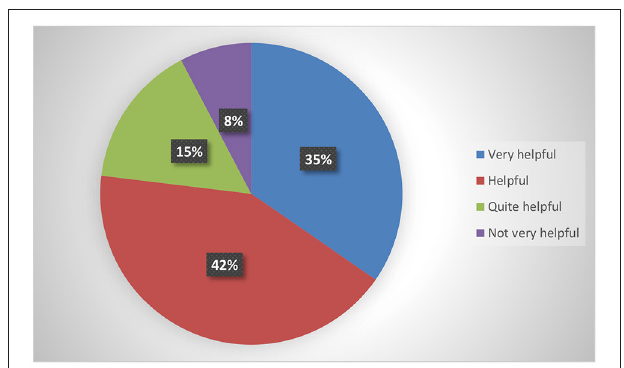
FIGURE 2 | Overall satisfaction with the